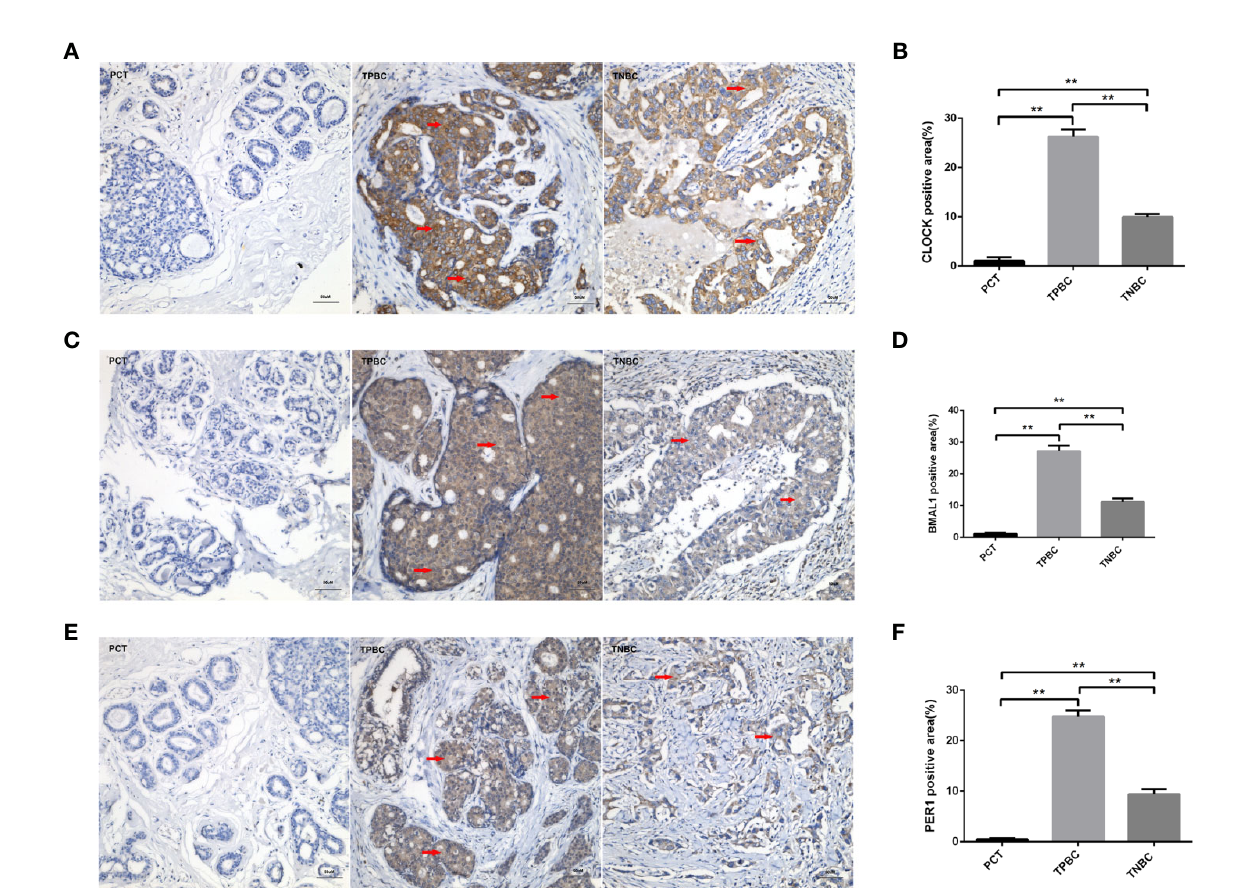
FIGURE 1 | Higher expression levels of the circadian clock proteins in TPBC compared with TNBC and para-carcinoma tissues (PCT). Immunostaining analysis using antibodies against CLOCK (A) , BMAL1 (C) , and PER1 (E) on tumor sections and PCT. The nuclei were stained with Hematoxylin (blue). Red arrows were used to indicate the positive area. (B, D, F) Quanti fi cation of CLOCK, BMAL1 and PER1 positive areas relative to total areas. Data are the mean ± SEM (TPBC,n=30; TNBC, n=25; PCT, n=8). ** p <